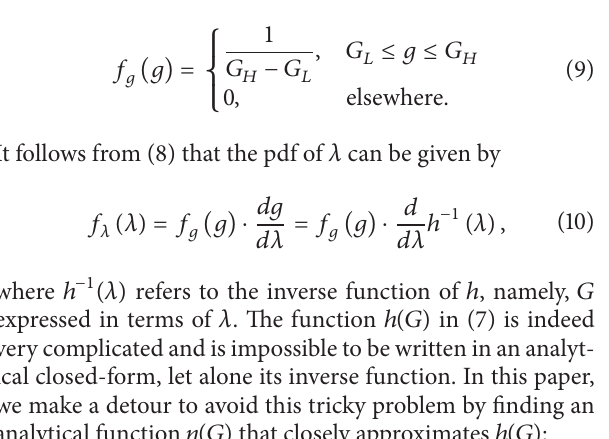
Figure 2: 𝑃 - 𝑉 curves of the module. The locus of maximum power is traced by a dashed curve that passes through the peak of each 𝑃 - 𝑉 curve.